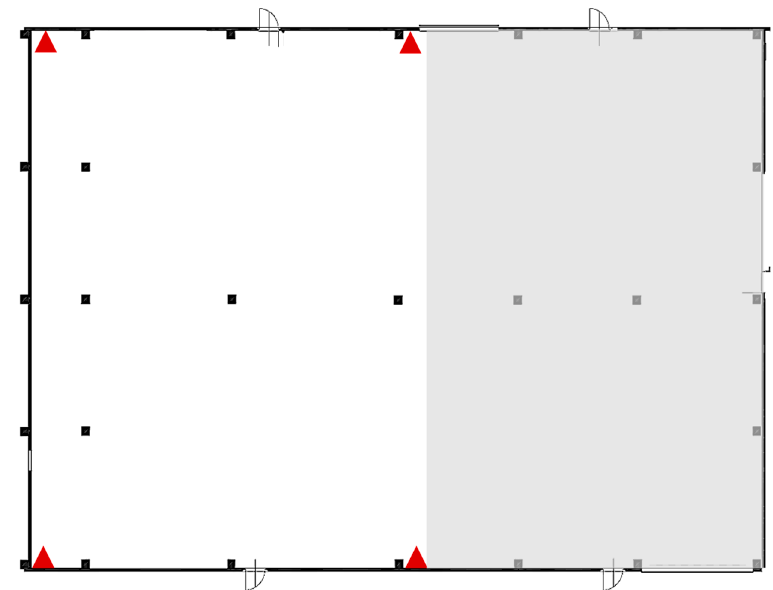
Figure 17. Area of interest used for Test 1.